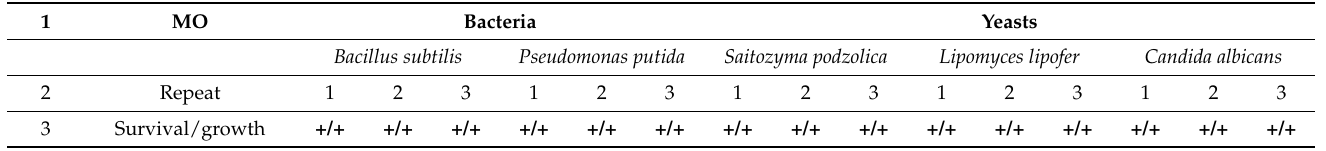
Table 3. Effect of ACP# on the viability of microorganisms.